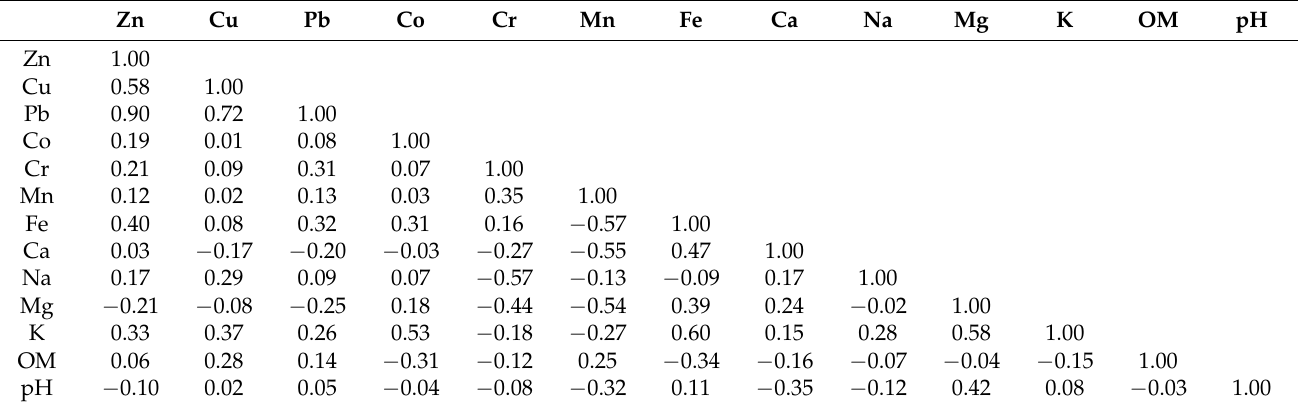
Table 5. Spearman correlation matrix between heavy metal concentrations and sediment